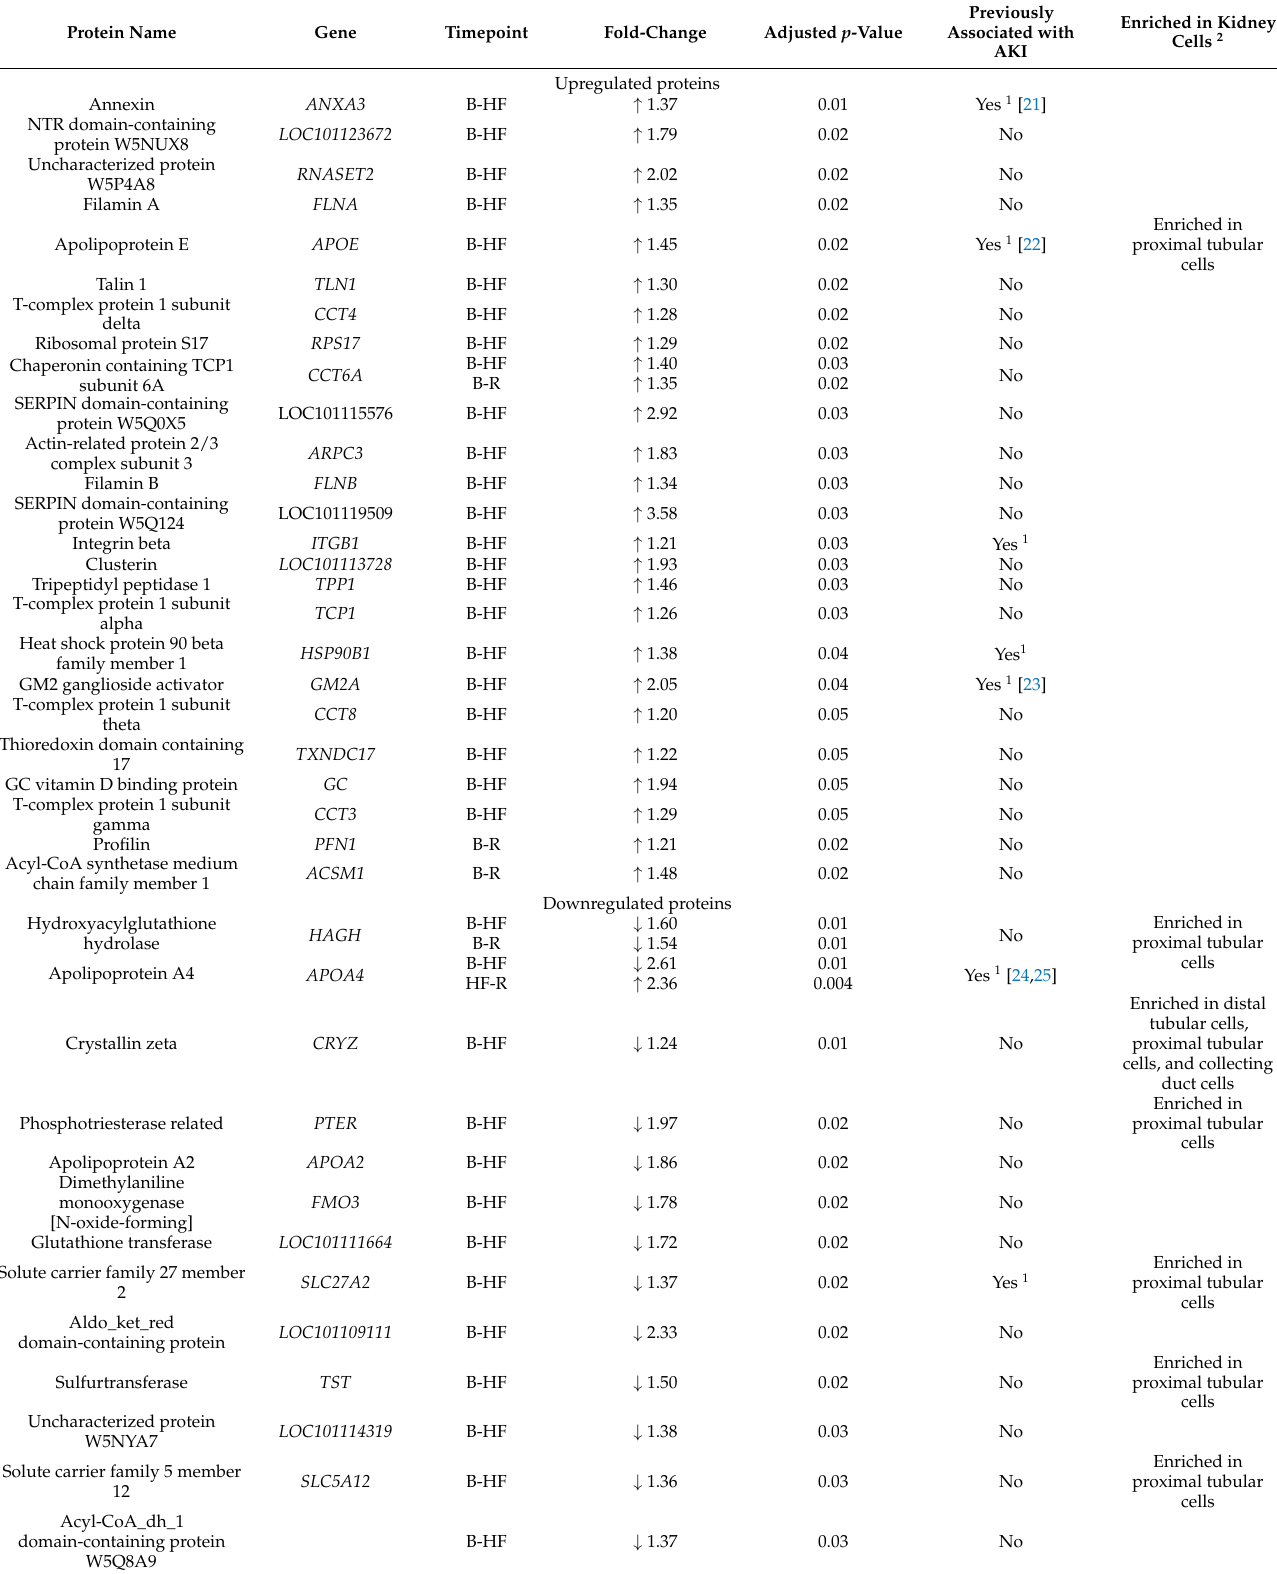
Table 1. Proteins of differential abundance between timepoints with a fold-change ≥ 1.2